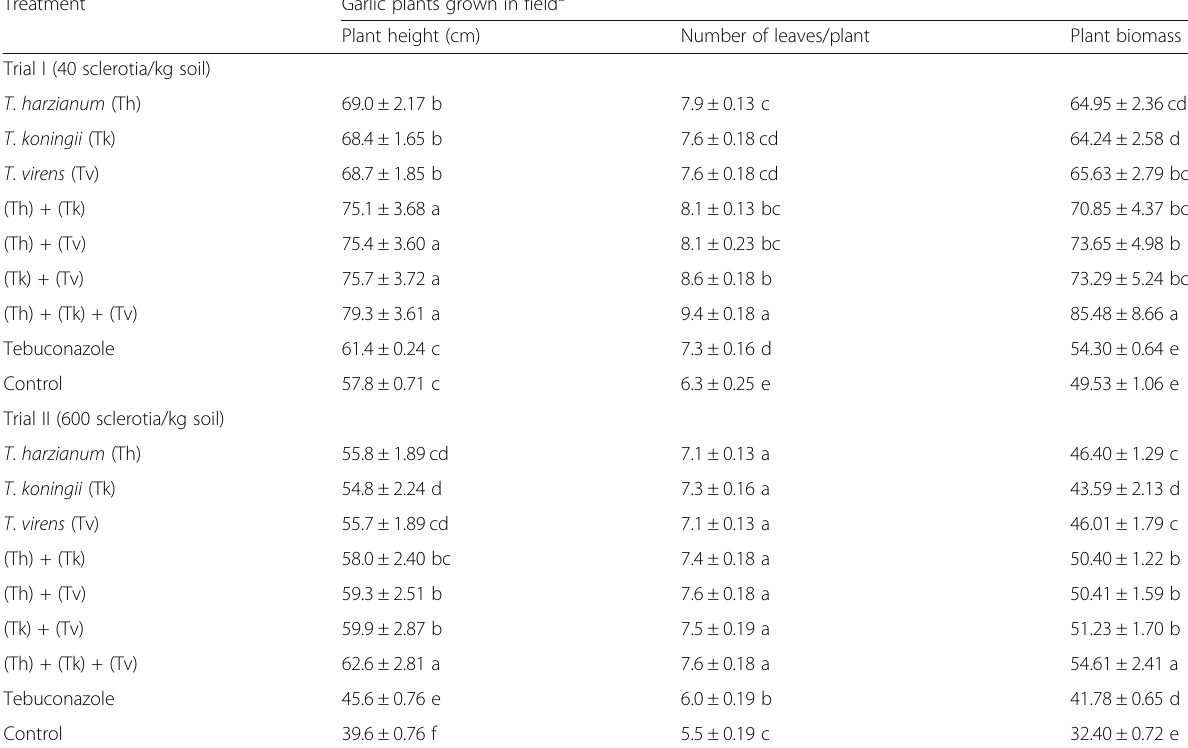
Table 6 Effects on plant height, number of leaves/plant, and plant biomass of garlic plants under field conditions at 100 days after planting